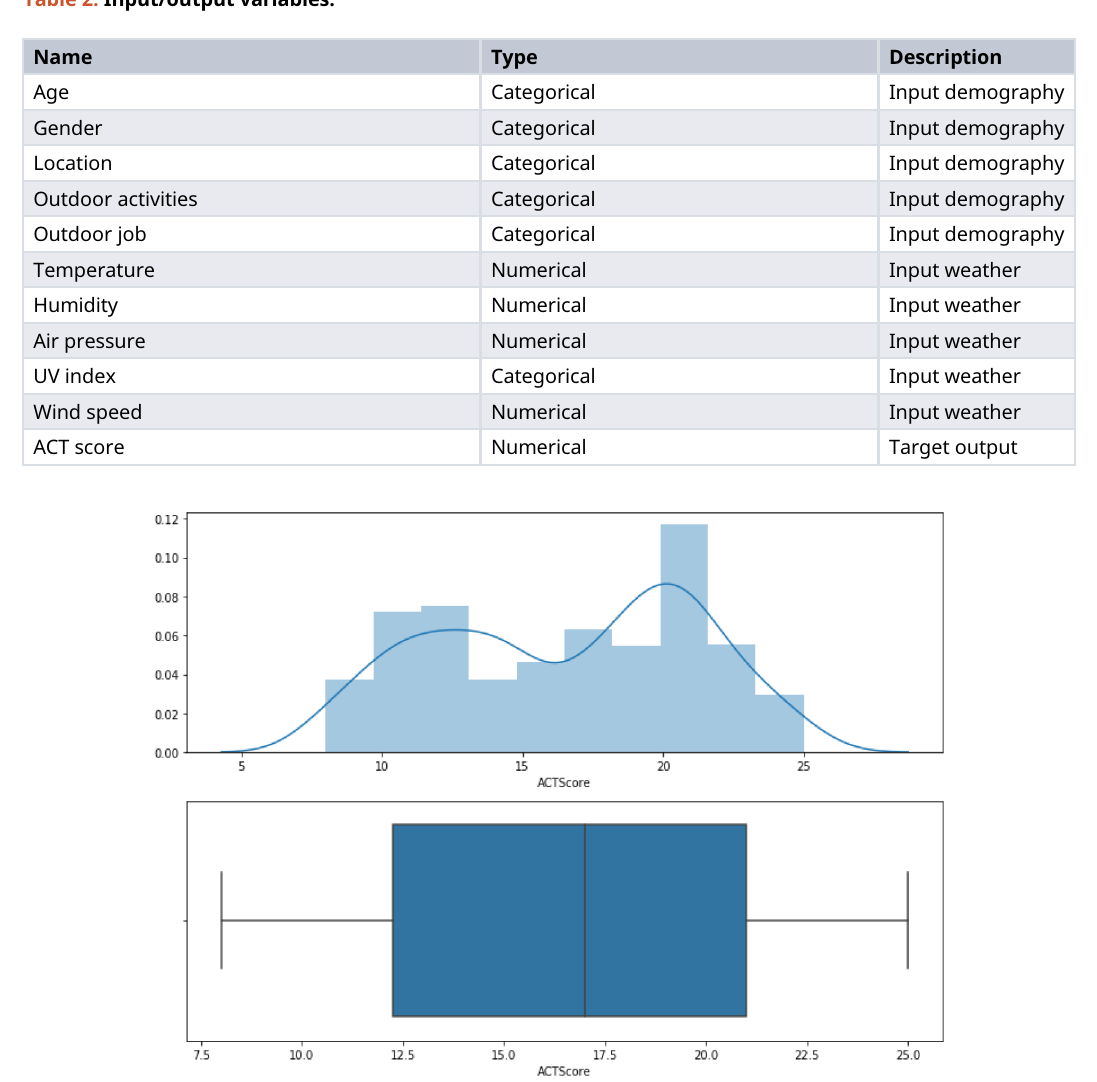
Table 2. Input/output variables.